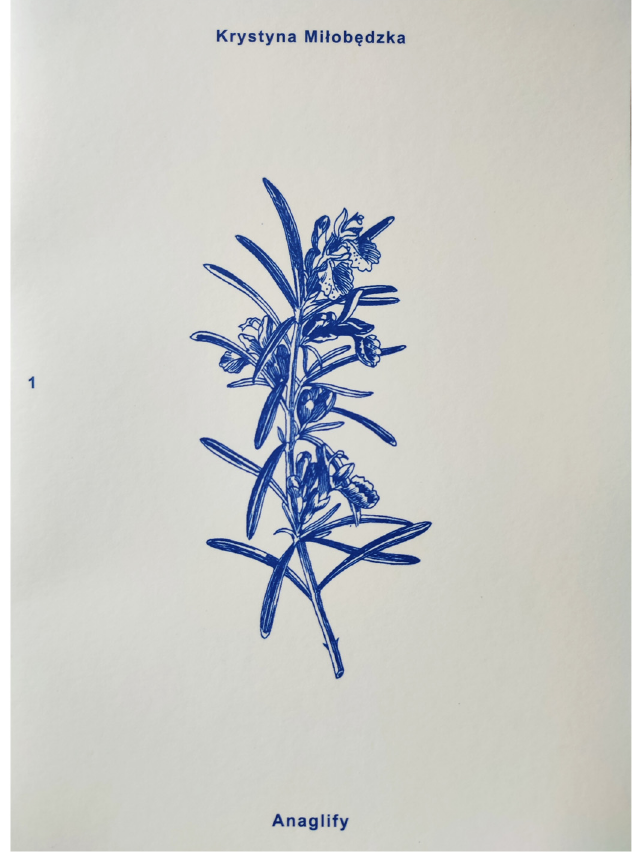
Figure 7. Cover by Marcin Markowski In: ( Mi ł ob ę dzka 2019).